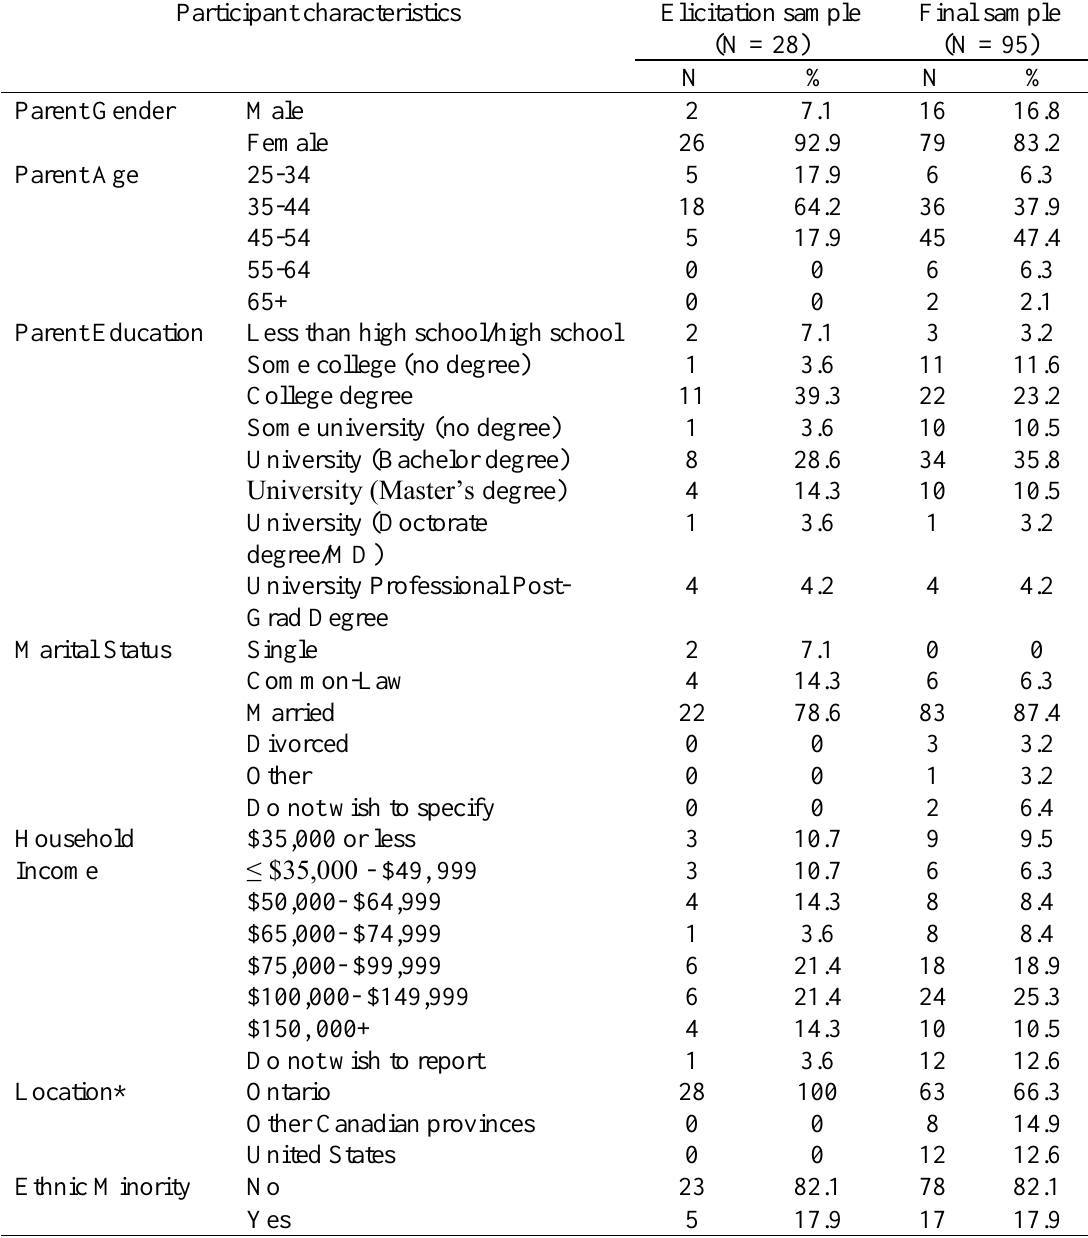
Table 3. Participant demographic characteristics for elicitation and final